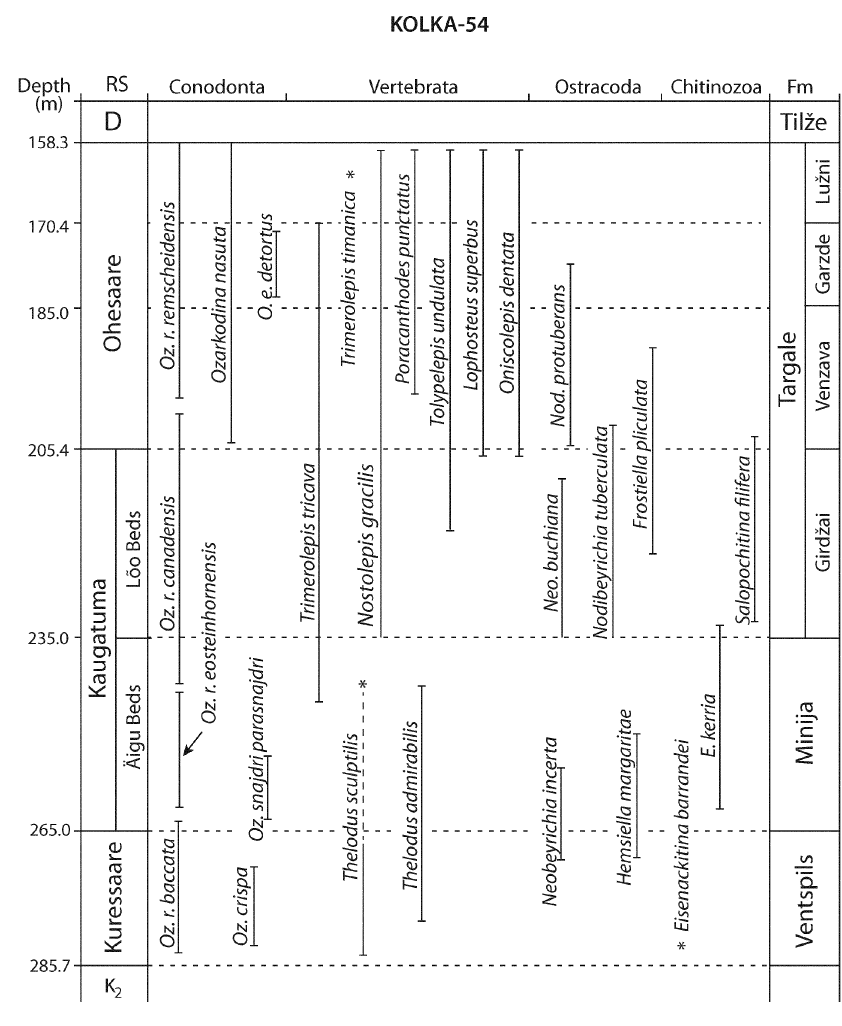
Fig. 4. Ranges of the most important conodont, vertebrate, ostracode and chitinozoan species in the Kolka-54 core section, based on partly modified data from Viira (1999), Märss (1986) and Sarv (1977) and new data by V.